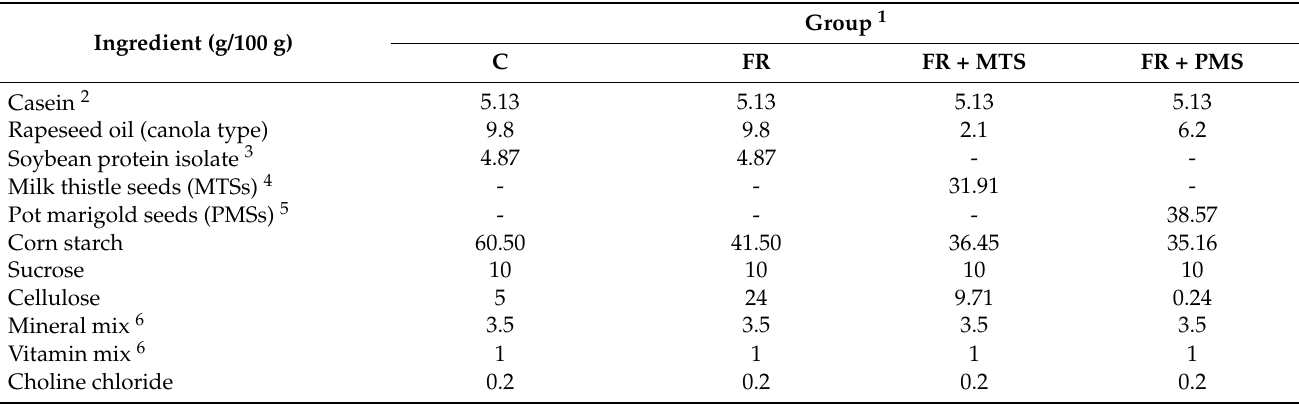
Table 5. Composition of the